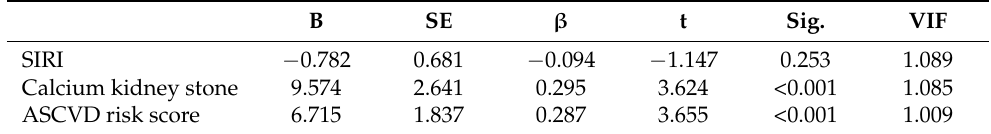
Table 4. Multivariate linear logistic regression analysis for severity of carotid artery stenosis.